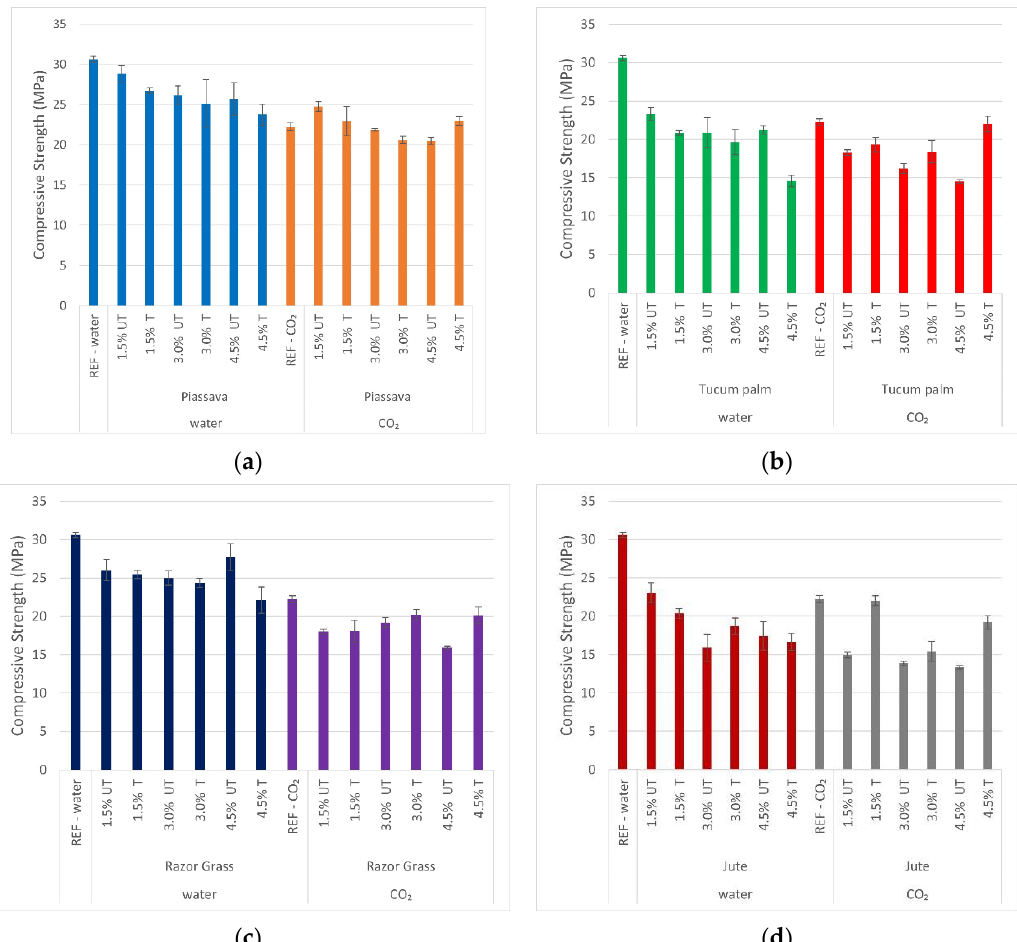
Figure 7. Mortars’ compressive strength at 28 days obtained with samples cured with water and CO 2 : ( a ) 1.5%; 3.0%; 4.5% piassava mortars; ( b ) 1.5%; 3.0%; 4.5% tucum palm mortars; ( c ) 1.5%; 3.0%; 4.5% razor grass mortars; ( d ) 1.5%; 3.0%; 4.5% razor grass mortars; REF — specimen without fiber; UT — untreated fiber mortar; T — treated fiber mortar; water and CO 2 — cured methods.